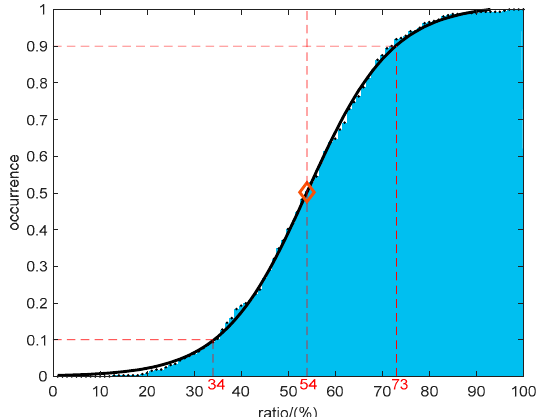
Figure 10. RMSE ratio distribution histogram before and after calibration for 2013–2015. Black dots show the probability of RMSE ratio below this ratio, and black line represents logistic fit results. The vertical dashed line with red lozenge outlines the maximum slope of fitting.